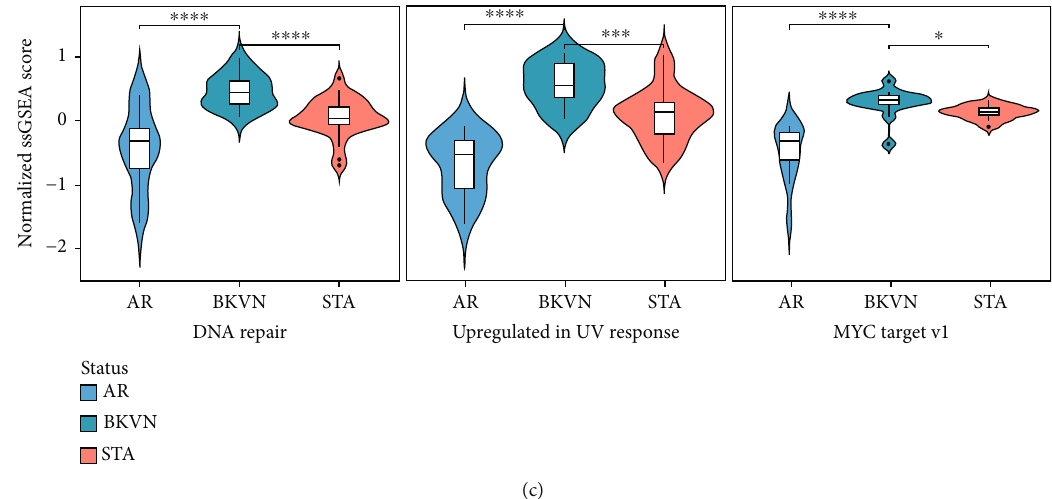
Figure 2: Screening of hallmark activities for BKVN. (a) Heat map of the ssGSEA scores for representative hallmark activities among AR, BKVN, and STA samples. (b) Lollipop chart shows top-ranked 10 hallmarks in BKVN vs STA (left) and BKVN vs AR (right) ordered by Gini importance through RF algorithm. (c) Violin diagram exhibits signi fi cant di ff erences in BKVN-speci fi c hallmarks among AR, BKVN, and STA samples. AR: acute rejection. STA: stable. ∗ P < 0 : 05 ; ∗∗∗ P < 0 : 001 ; ∗∗∗ ∗ P < 0 : 0001